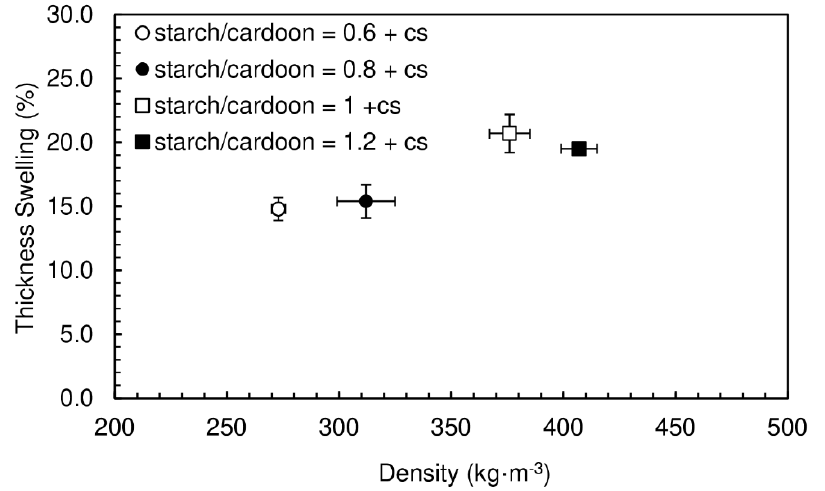
Figure 5. Thickness swelling of particleboards bonded with potato starch for starch/cardoon ratios of 0.6, 0.8, 1 and 1.2. All formulations had chitosan/starch ratio of 0.05 and water/starch ratio of 2.